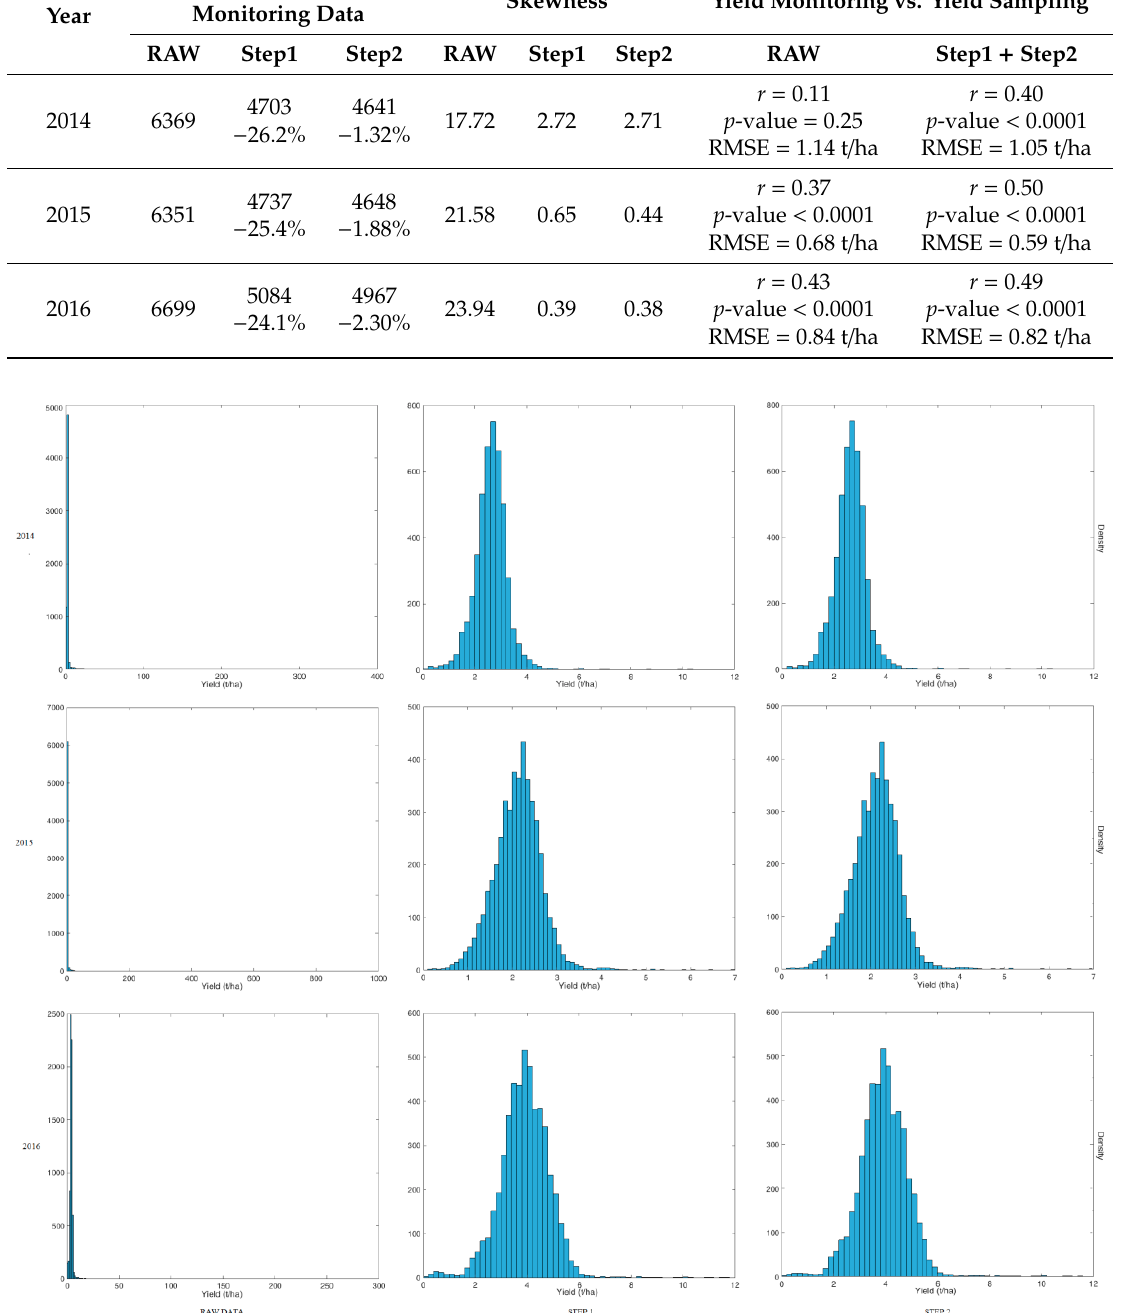
Figure 2. Distribution of yield monitoring datasets for uncleaned and cleaned yield data (data not interpolated).